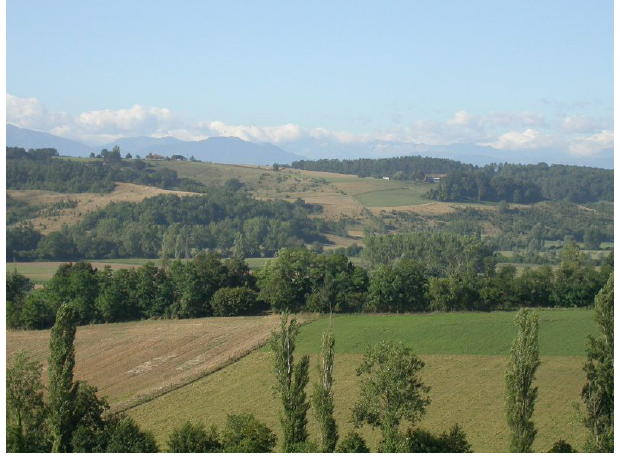
Fig. 1. Photograph of some of the small private forests included in the case